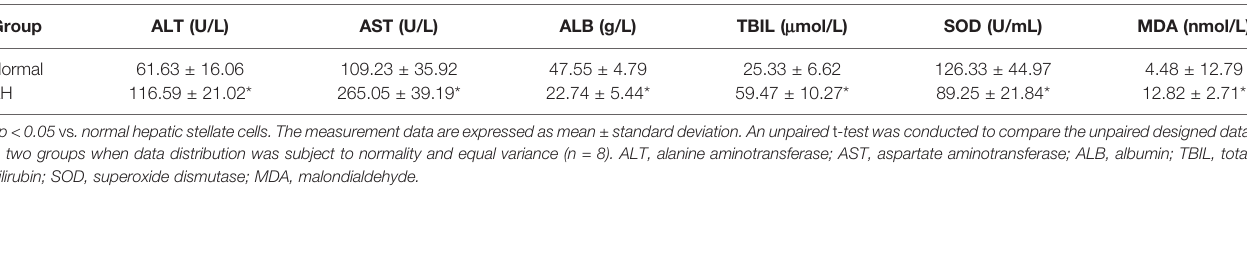
TABLE 2 | Blood lipid levels of